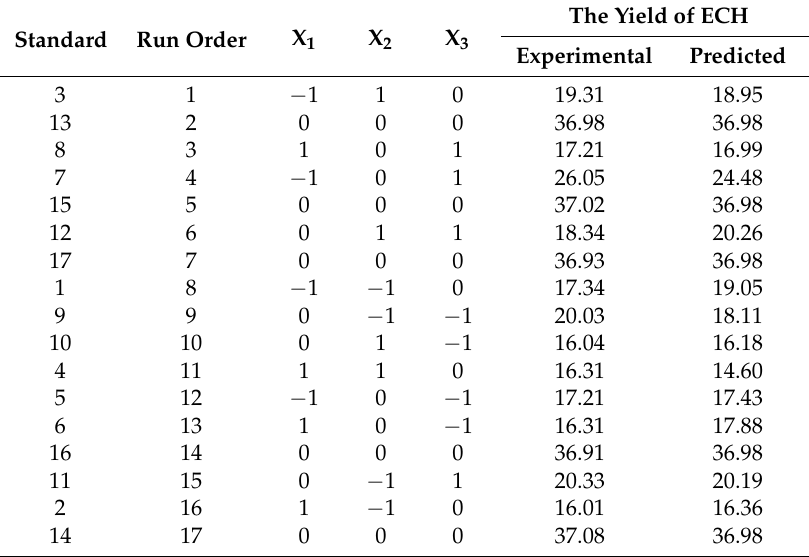
Table 1. Design and experimental results of Box–Behnken design.